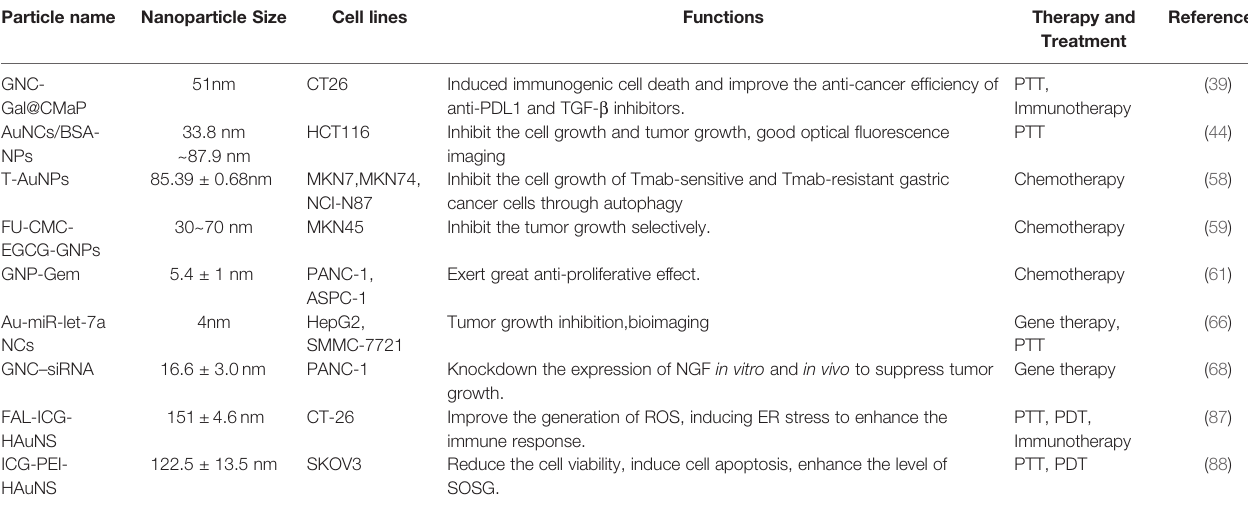
TABLE 2 | The important uses of GNPs in the treatment and therapy of gastrointestinal